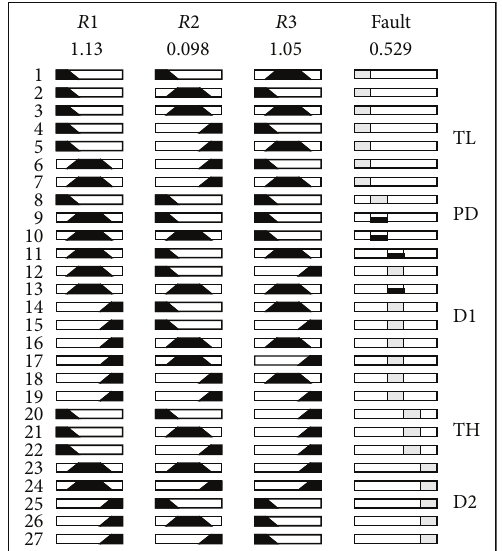
Figure 5: Rule viewer for